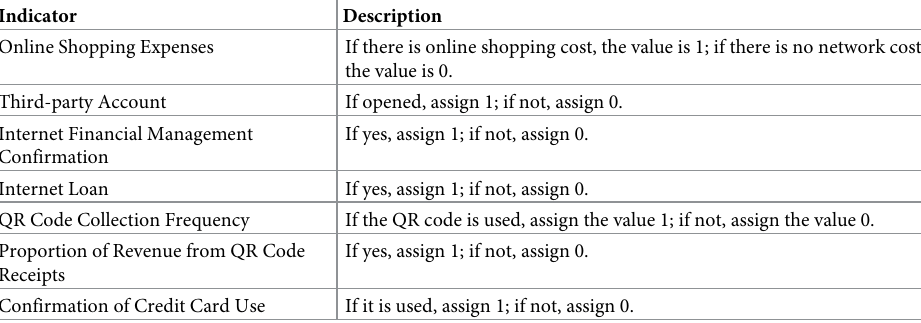
Table 3. Composition indicators of digital finance index.